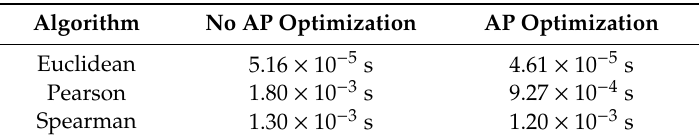
Table 8. Time statistics before and after AP optimization.